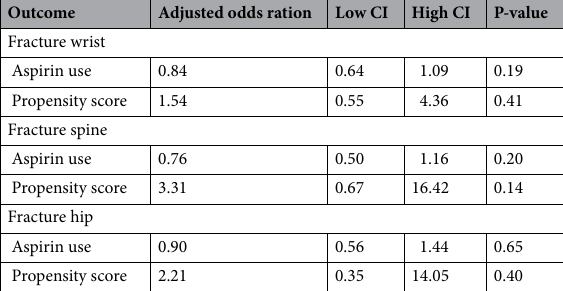
Table 5. Multiple Logistic regression after propensity Score